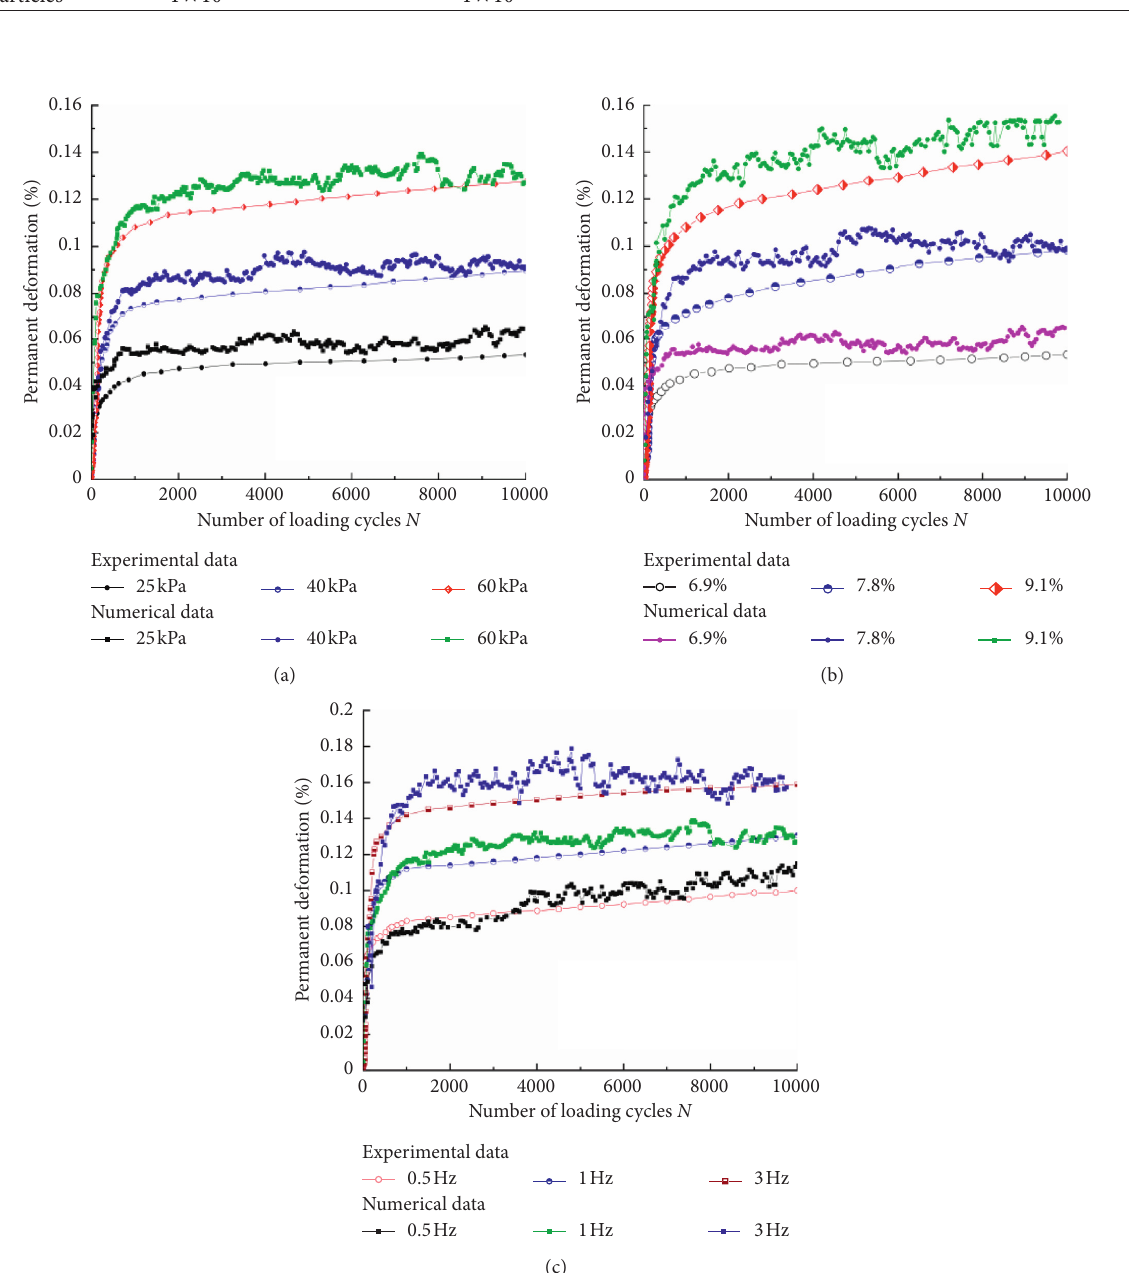
Figure 6: Permanent deformations of samples in laboratory tests and numerical simulations. (a) At different deviatoric stress amplitudes ( w � 6.9% and f � 1 Hz). (b) At different moisture contents ( σ w � 6.9%).